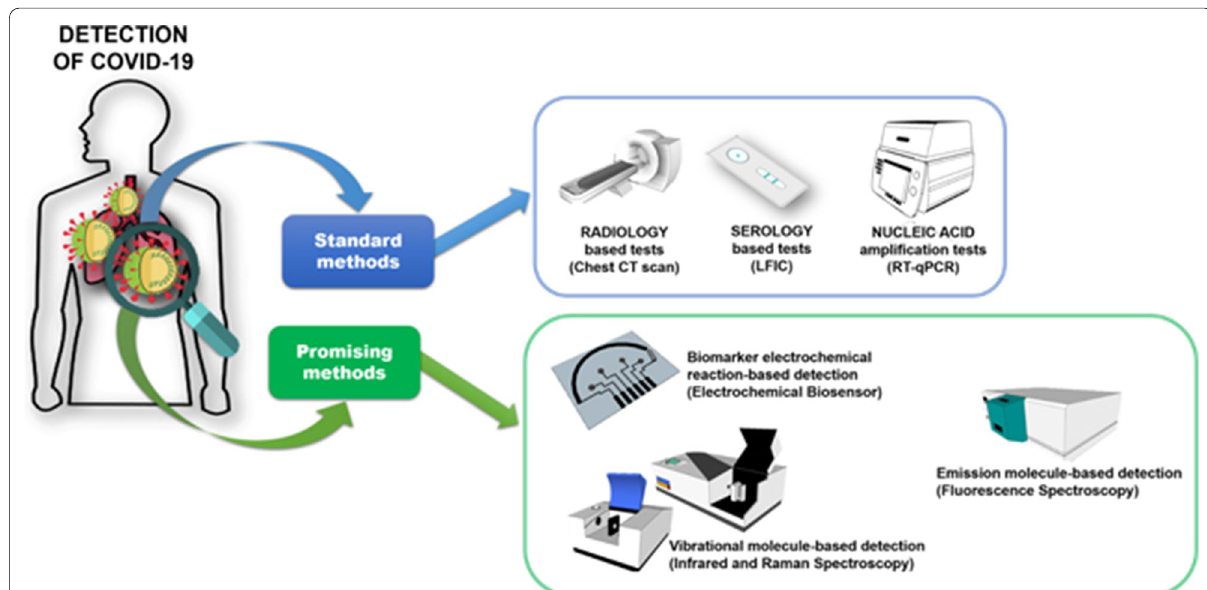
Fig. 11 Schematic illustration of various detection methods for SARS-CoV-2 [219]. Reproduced with permission. Copyright © 2021 IOP Publishing